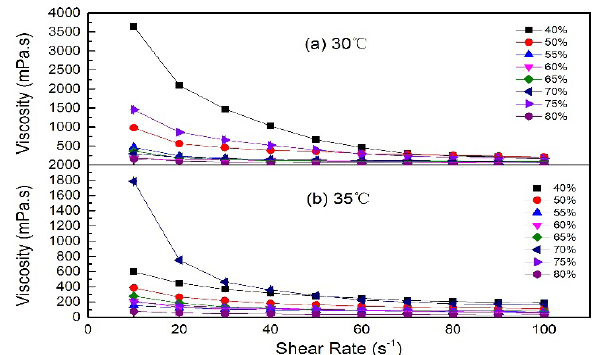
Figure 2: The influence of polymer concentration (503mg/L ) on rheological behaviors at the temperatures (a)